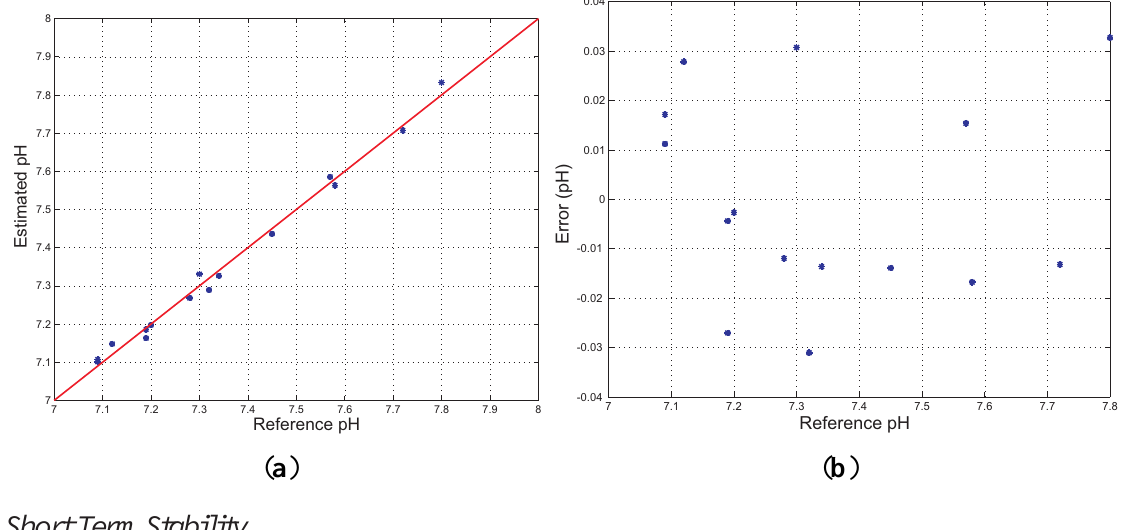
Figure 10. ( a ) Estimated versus reference pH and fitting line. ( b ) Difference between estimated and reference pH versus reference